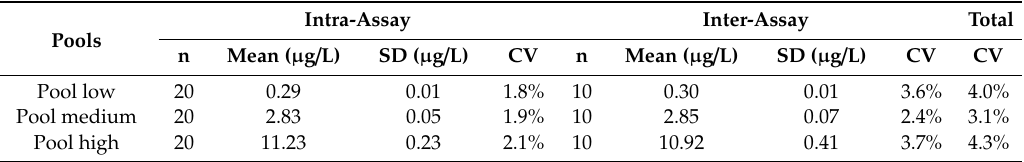
Table 1. Analytical imprecision of the Beckman Coulter Access procalcitonin (PCT) immunoassay. Intra-Assay Pools